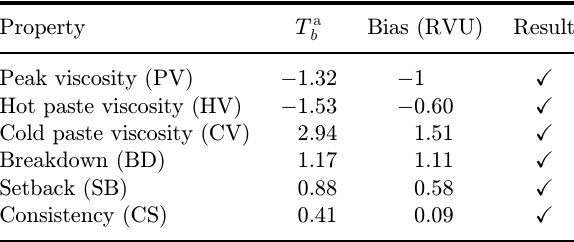
Table 4. The statistic test of SD of the residuals for model